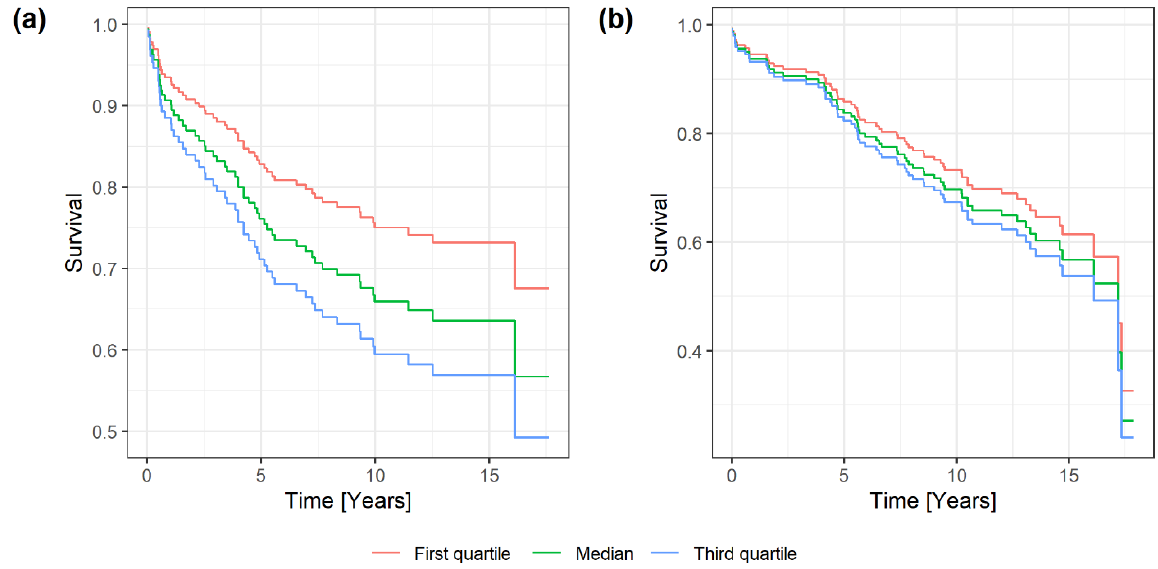
Figure 5. Univariate Cox regression survival plots for SSTR2, presented with 1st quartile, median and 3rd quartile; ( a ) SSTR2 related to time to recurrence (TTR); ( b ) SSTR2 related to overall survival (OS).